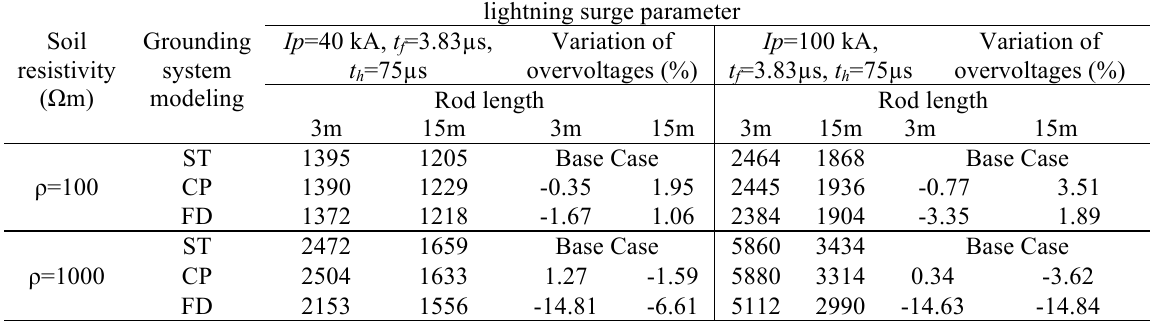
Figure 10: Maximum overvoltage across the insulator string, Left column: Stroke to shield wire: First stroke (100 kA\3.83 µ s\75 µ s), Right column: Stroke to phase conductor: Table 4: Maximum voltage across the insulator string (kV) for Rod-shape grounding system.